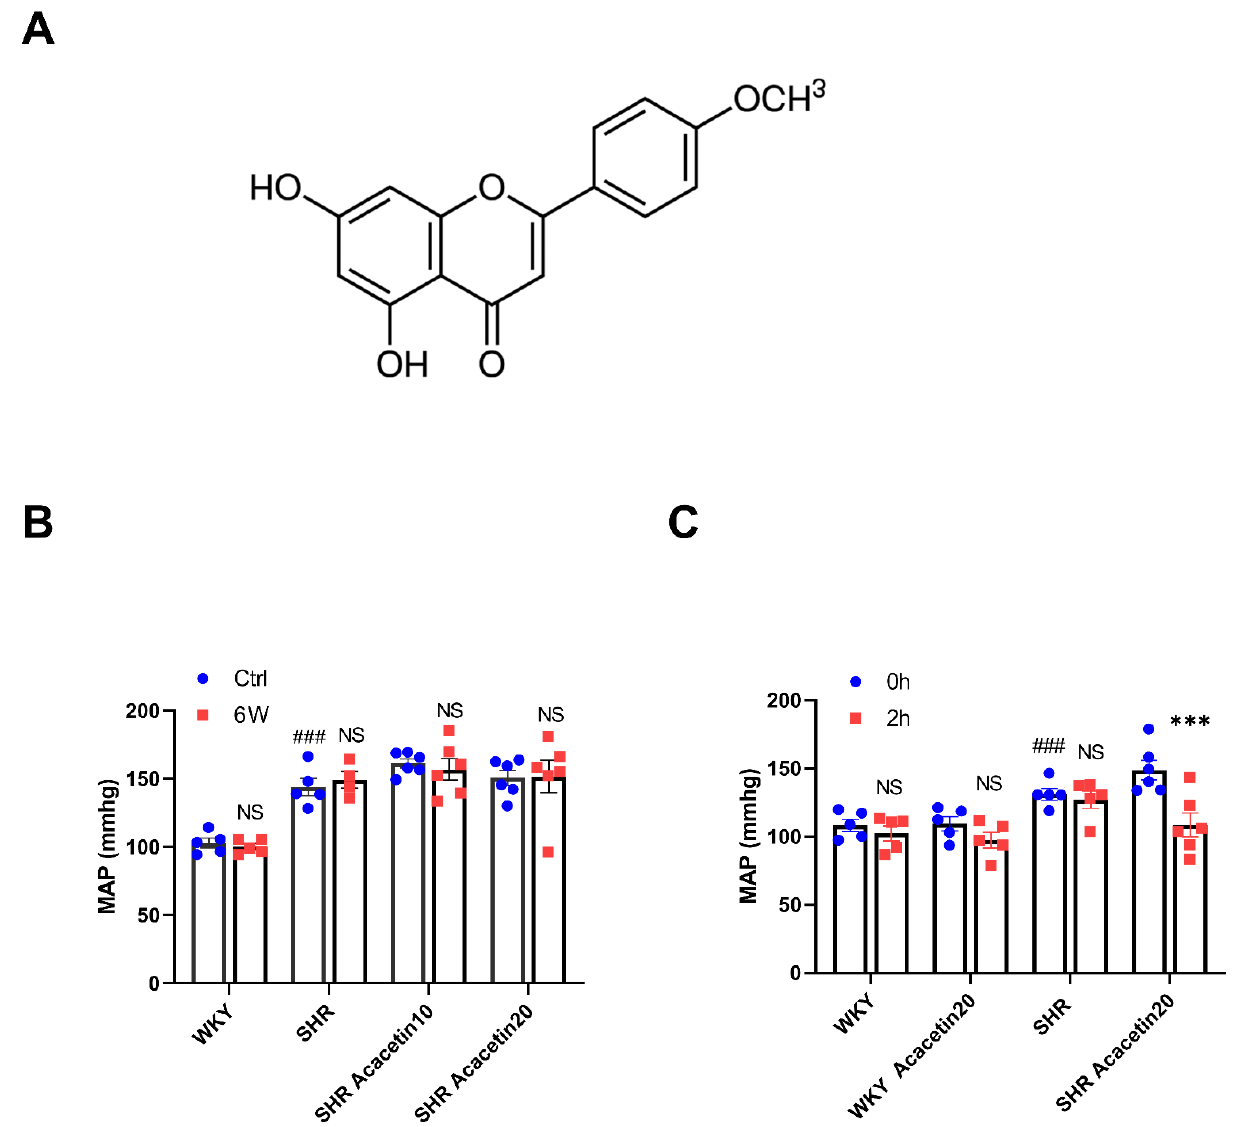
Figure 1. Acacetin reduced MAP in age-matched WKY rats and SHR. ( A ) The molecular structure of acacetin. ( B ) The blood pressure measured in WKY rats and SHR after intragastric administration of acacetin (10 and 20 mg/kg) for six weeks. A statistical analysis is shown by bar graph (NS indicated p > 0.05 vs. control group, ### p < 0.001 vs. WKY control group, n = 5 – 6 for each group). ( C ) The blood pressure monitored in SHR and WKY rats after being injected intraperitoneally with acacetin at 20 mg/kg. Statistical analysis was shown by bar graph (*** p < 0.001 vs. control group (0 h), ### p < 0.001 vs. WKY control group (0 h), n = 5 – 6 for each group).